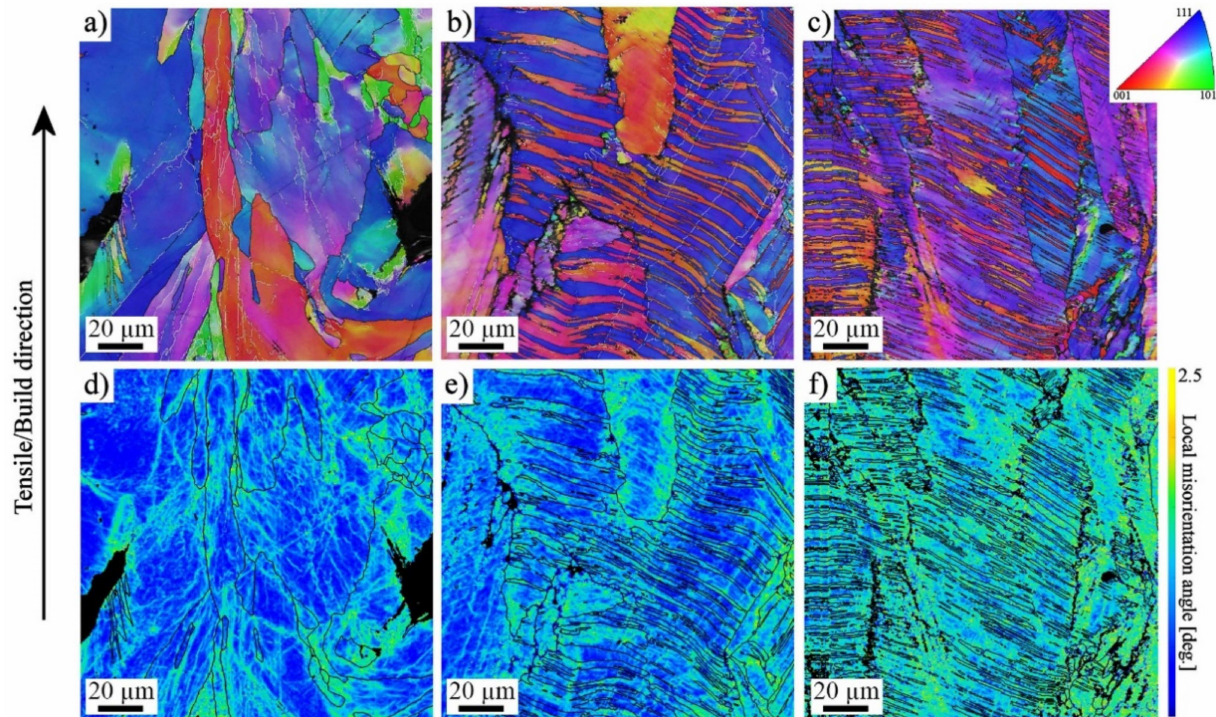
Figure 6. IPF and KAM maps of L-PBF 316L strained at the higher strain rate until UE, fabricated with the ( a , d ) low-; ( b , e ) medium-; ( c , f ) high-VED.